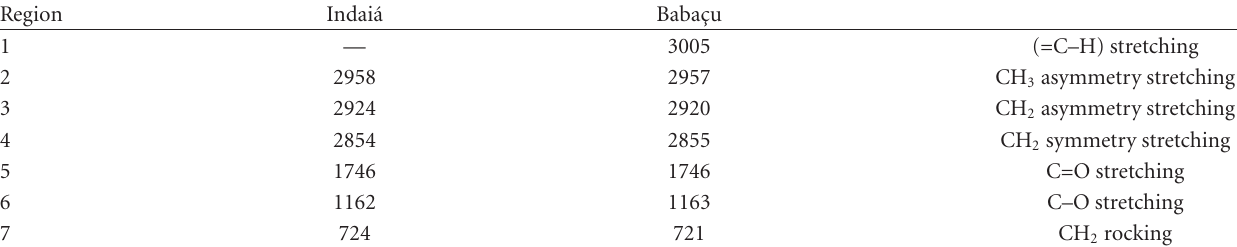
Table 4: Assignments of the FT-IR bands of indai´a and babassu oil